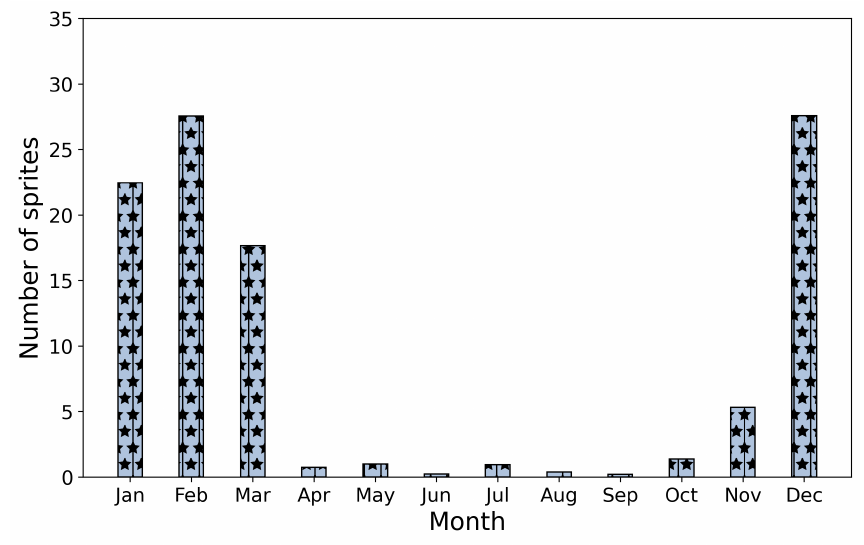
Figure 13. Estimated monthly number of sprites in case C (see caption of Table 1 for an explanation of the three different